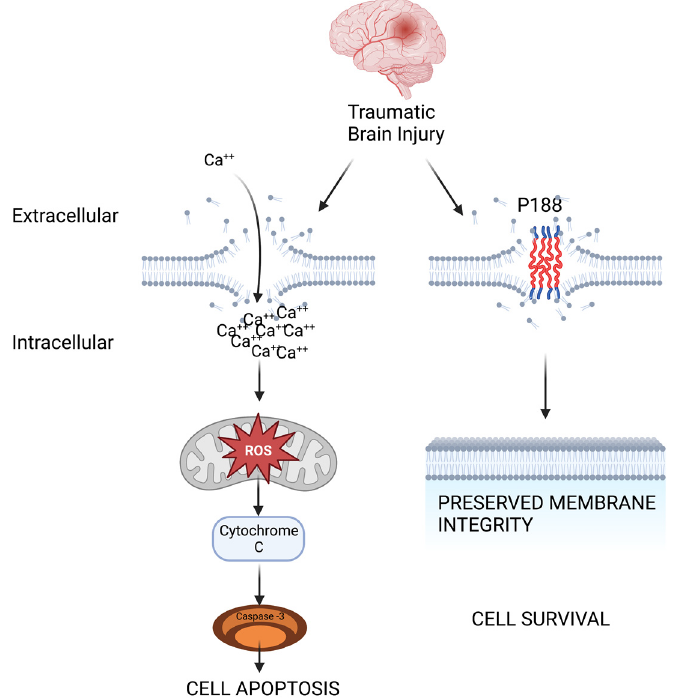
Figure 1. Schematic depicting how P188 mitigates TBI-induced cellular membrane permeability, thus preventing dysregulated calcium influx, reactive oxygen species (ROS) formation, and activation of apoptotic signaling cascades.